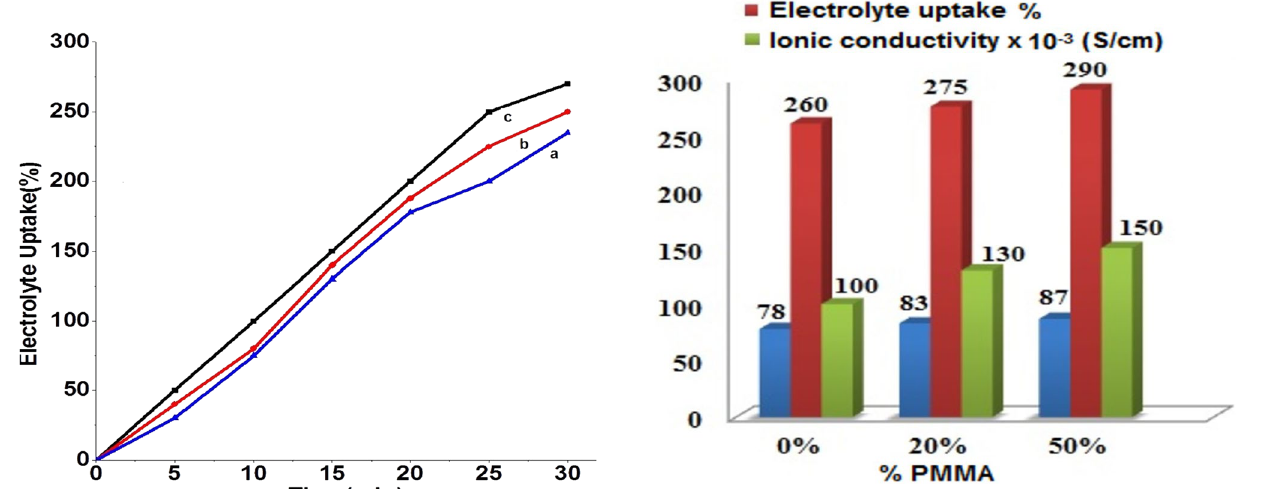
Fig. 6 Electrolyte uptake of a PVdF, b PVdF–PMMA (80:20), and c PVdF–PMMA (50:50) nanofibrous membranes